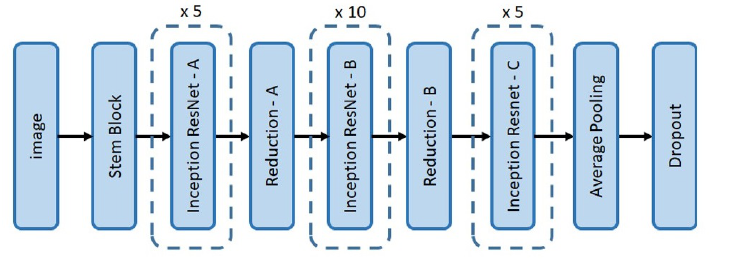
Figure 10. Network architecture of ResNet101.